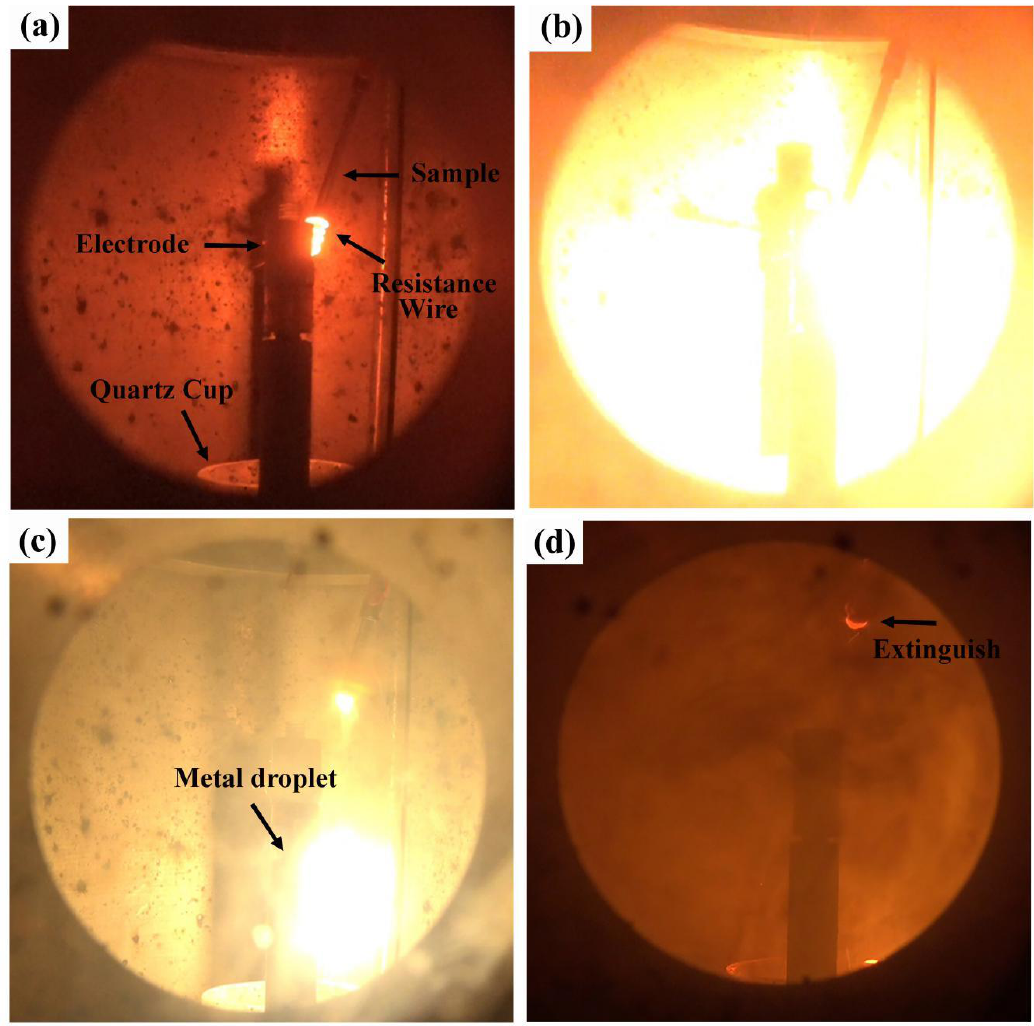
Figure 2. In suit picture during the combustion of Ti-V-Cr alloy samples. ( a ) Heating by resistance wire, ( b ) ignition, ( c ) combustion and ( d ) extinguished sample.